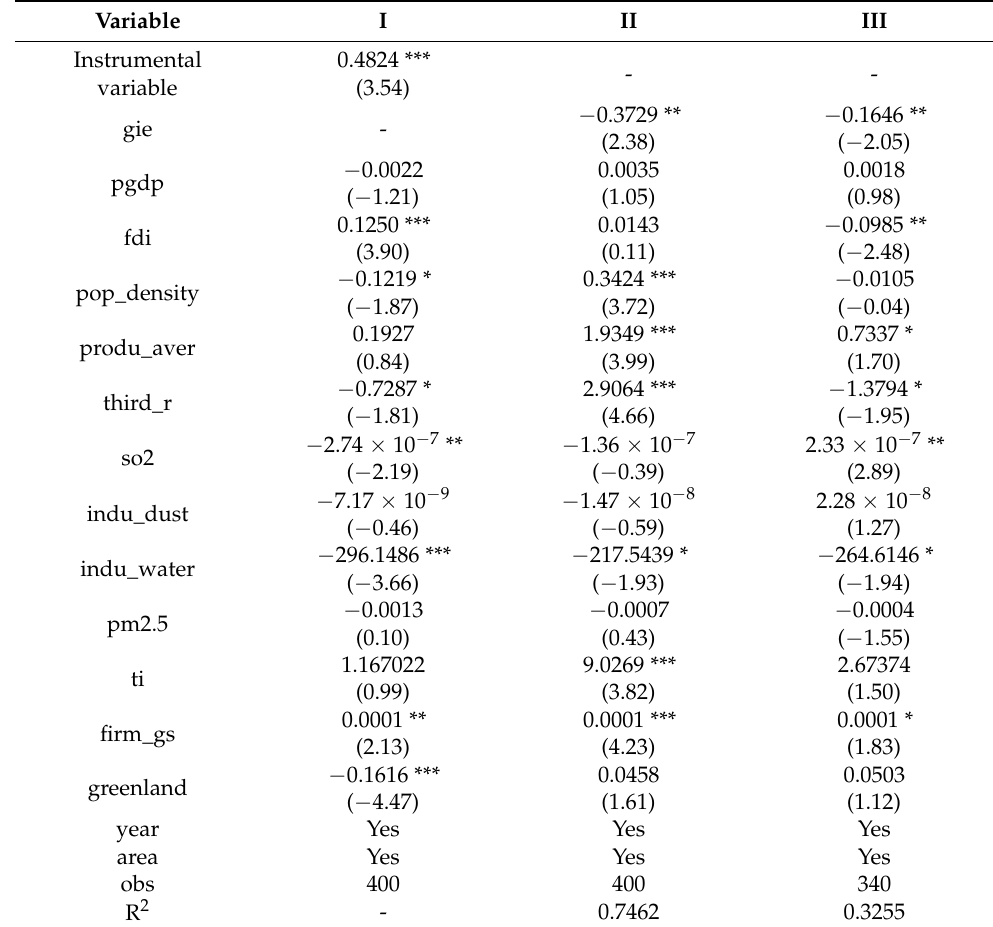
Table 3. Results of two-stage least squares